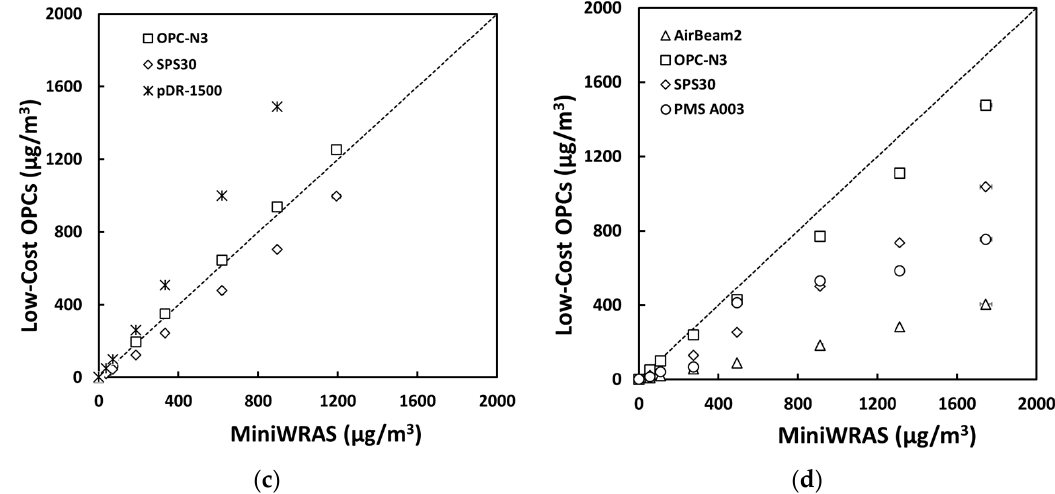
Figure 7. The mass concentrations (µg/m 3 ) of ( a ) PM 1 , ( b ) PM 2.5 , ( c ) PM 4 mc, and ( d ) PM 10 reported by the sensors plotted against the reference device for the PAO-4 oil occupational experiment.